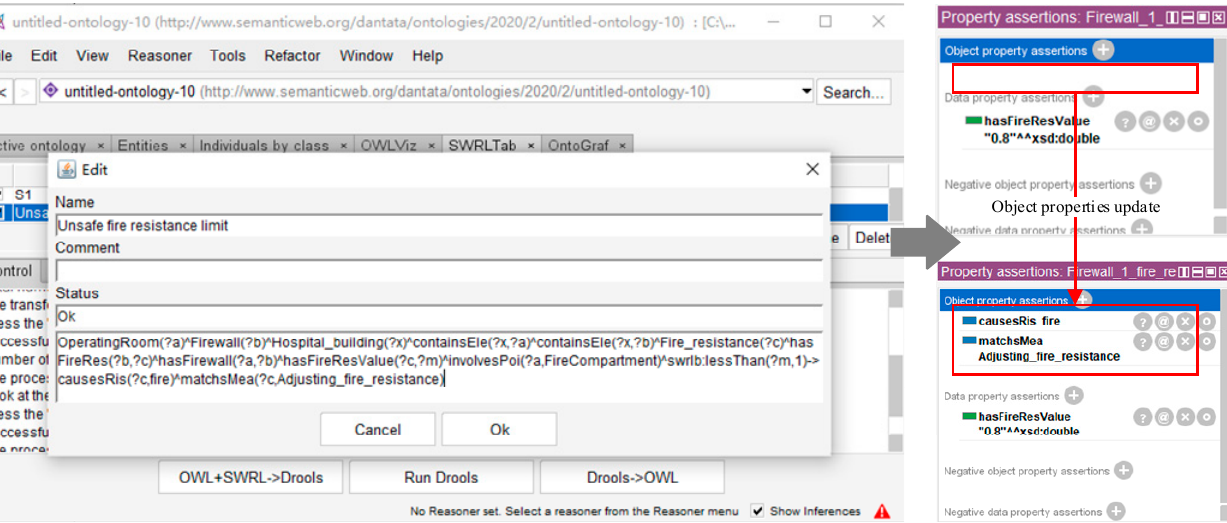
Figure 17. Ontology reasoning of the Drools inference engine based on SWRL.